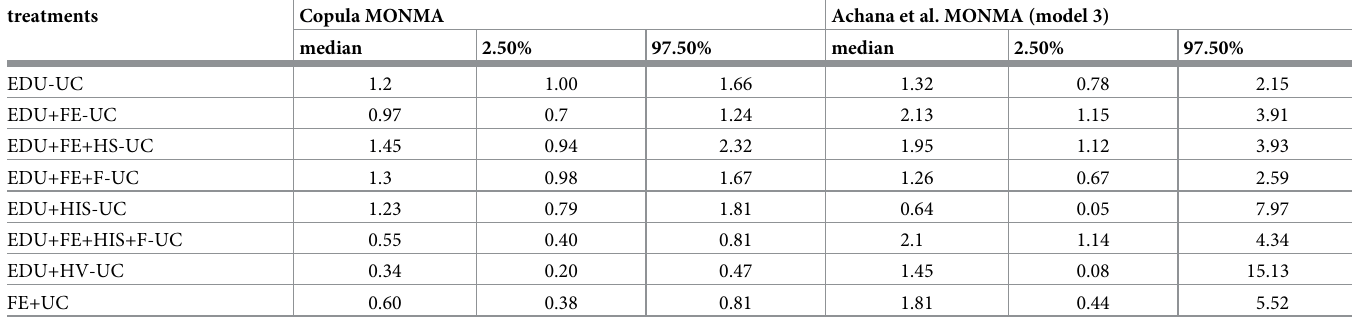
Table 2. Safe storage of other household products: Pooled effects median and HPD 95% credibility intervals.